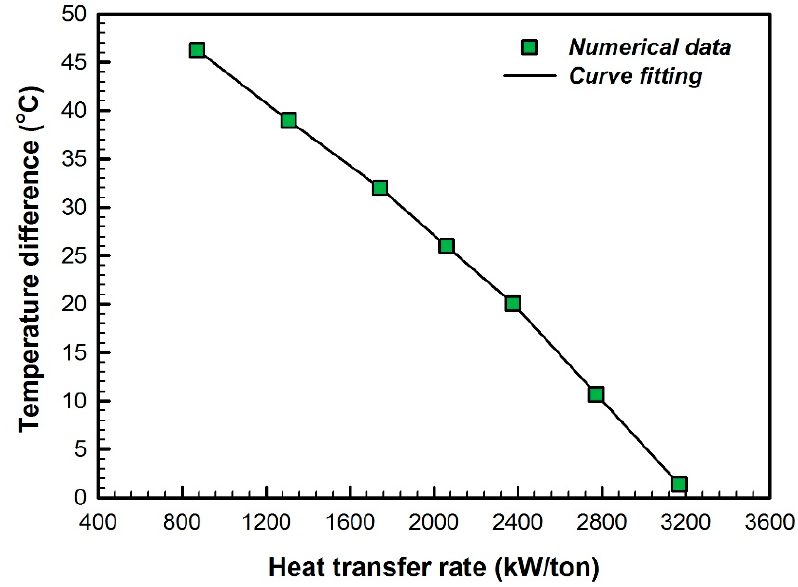
Figure 15. Relationship between the temperature differences in the transfer bars and the fuel used. 309